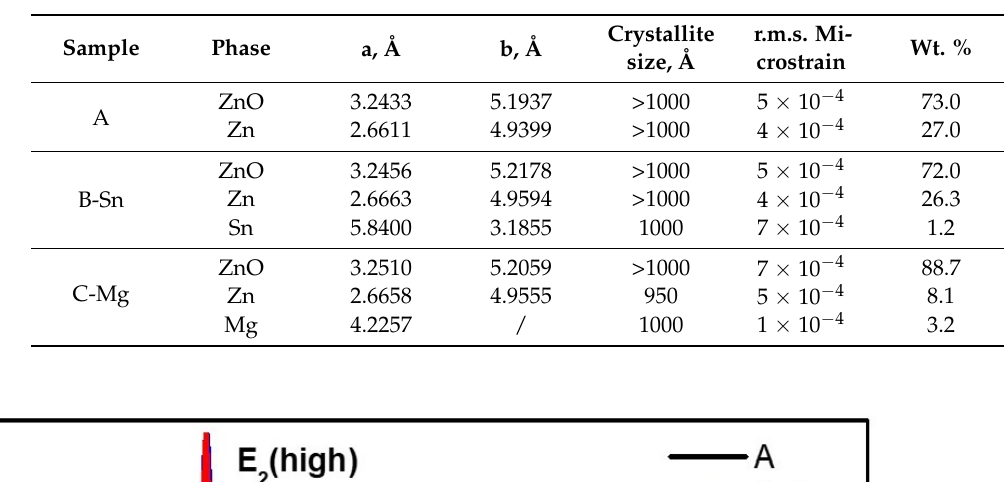
Table 1. Quantitative analysis of the crystalline phases, cell parameters, average crystallite sizes, and